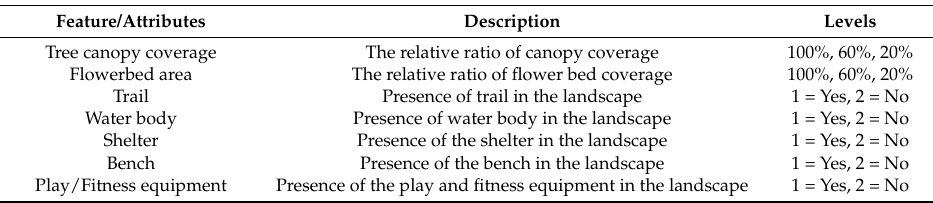
Table 1. Features and associated levels in choice